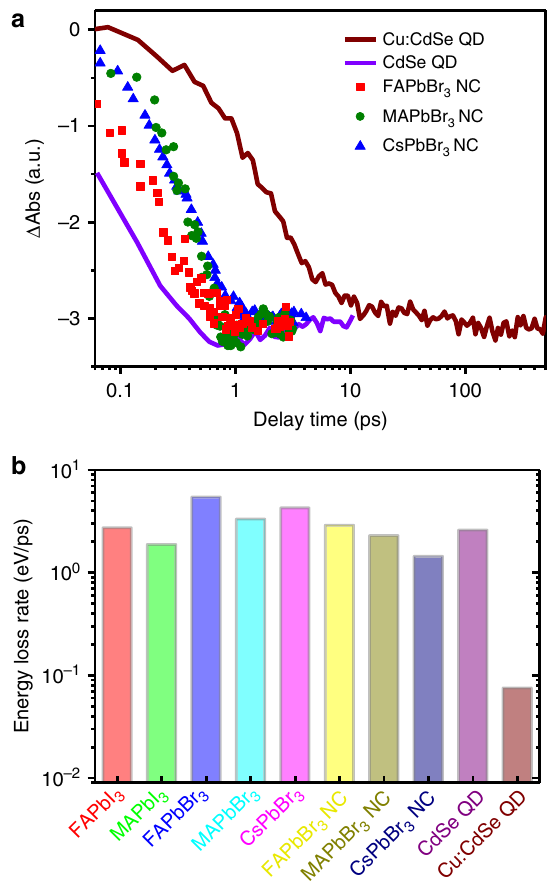
Fig. 5 Comparison to lead halide perovskites. a Exciton bleach formation kinetics of CdSe (purple line) and Cu:CdSe QDs (wine line) in this study (400 nm pump) and FAPbBr 3 (red squares), MAPbBr 3 (green circles), and CsPbBr 3 (blue triangles) NCs adapted from ref. 8 (350 nm pump). All the kinetics were measured under sub-single-exciton conditions. b Hot carrier energy loss rates calculated for FAPbI 3 , MAPbI 3 , FAPbBr 3 , MAPbBr 3 , and CsPbBr 3 bulk fi lms, FAPbBr 3 , MAPbBr 3 , and CsPbBr 3 NCs, and CdSe (purple) and Cu:CdSe QDs (wine). The data for perovskite bulk fi lms and NCs are adapted from refs. 7,8